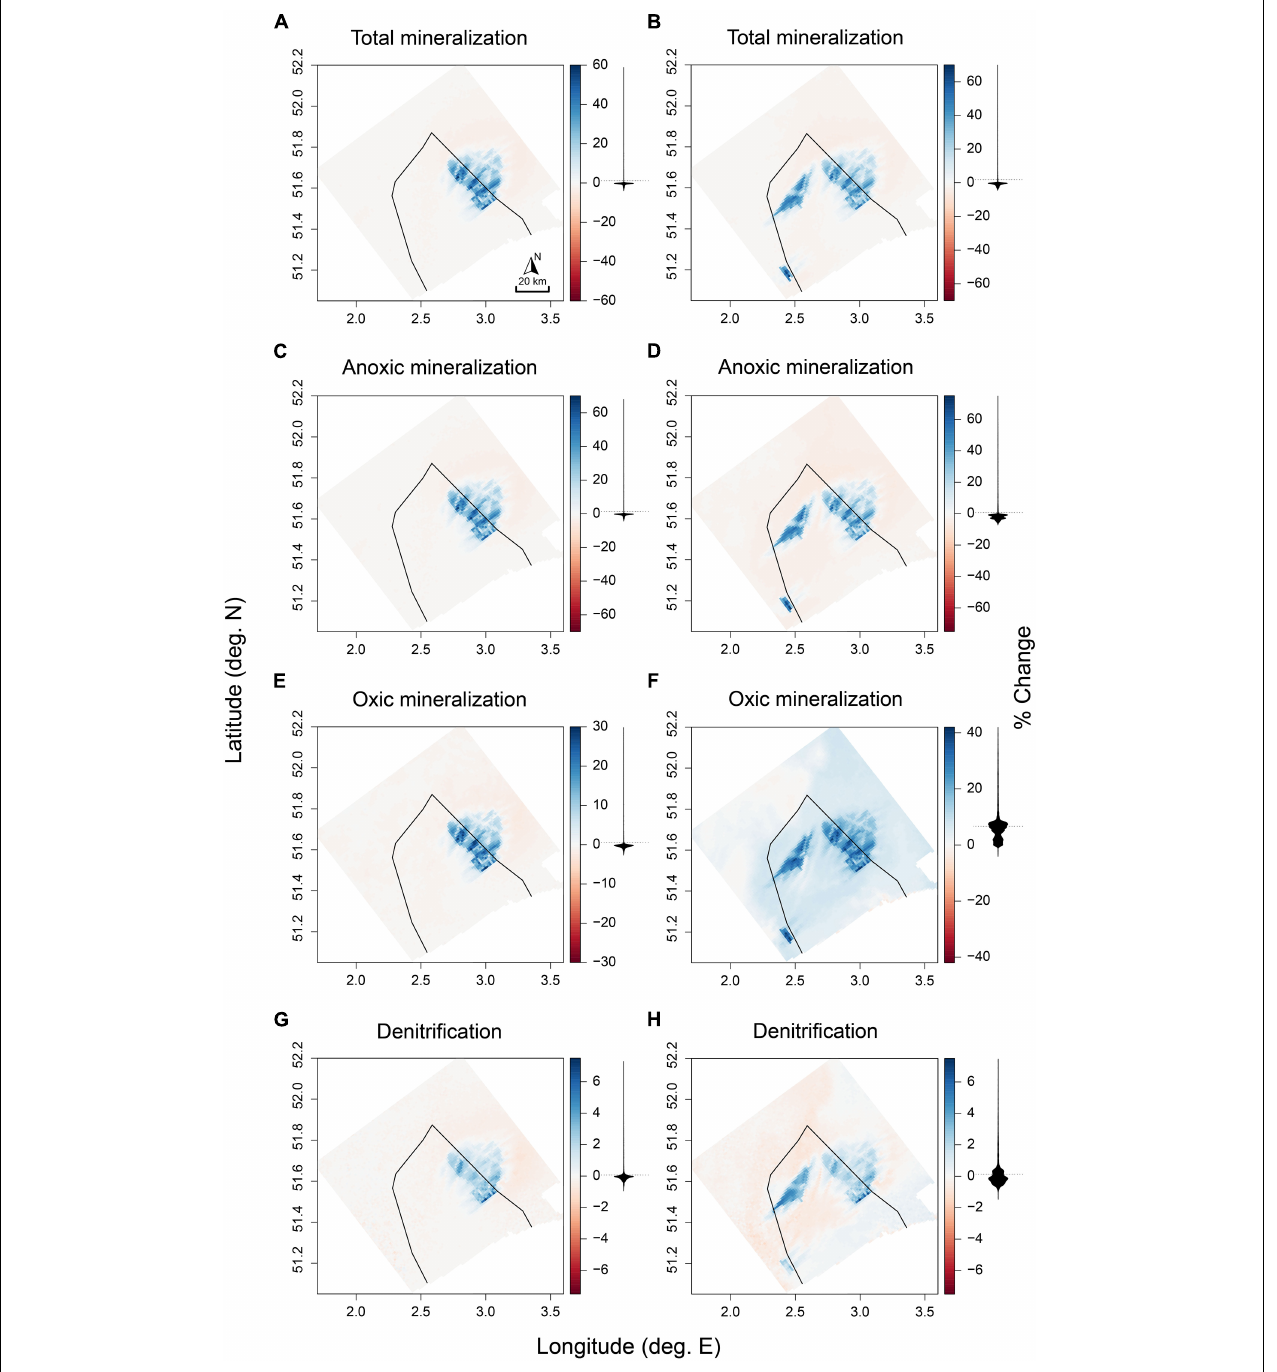
FIGURE 4 | Changes (in %) in rates of total mineralization (A,B) , anoxic mineralization (C,D) , oxic mineralization (E,F) , and denitrification (G,H) relative to the baseline scenarios for the “current” scenario (left column), and the “future” scenario (right column), with the BPNS outlined in black. Density distributions of the values are represented as black shapes corresponding to the axis from the color